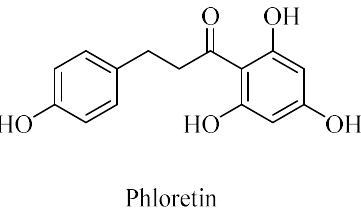
Figure 5. Structure of phloretin (from apple juice), an advanced glycation end product (AGE) inhibitor.